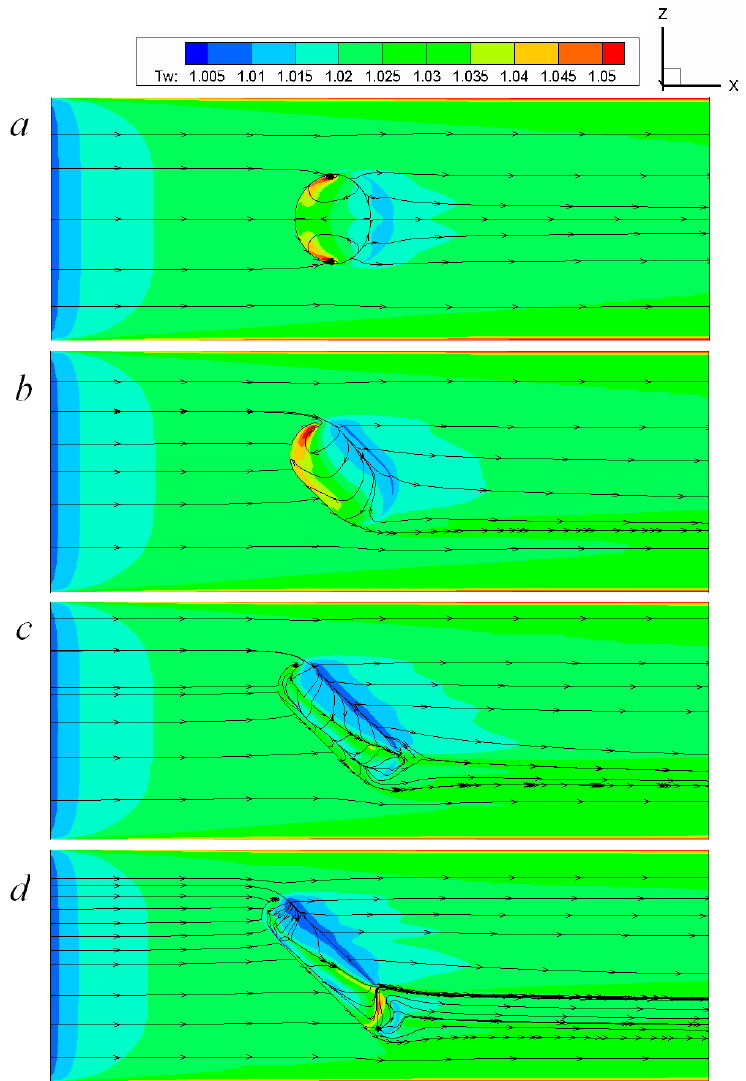
Figure 11. Temperature fields at the heated wall with oval dimples of width 1 ( a ), 0.731 ( b ), 0.549 ( c ), 0.429 ( d ) and the streamlines.